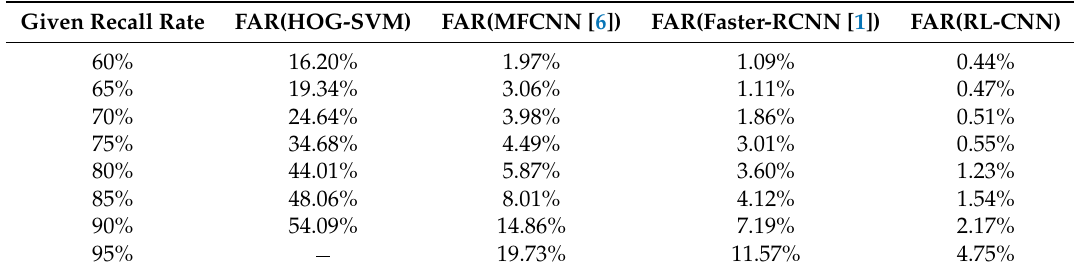
Table 6. False Alarm Rate (FAR) of four detection models.